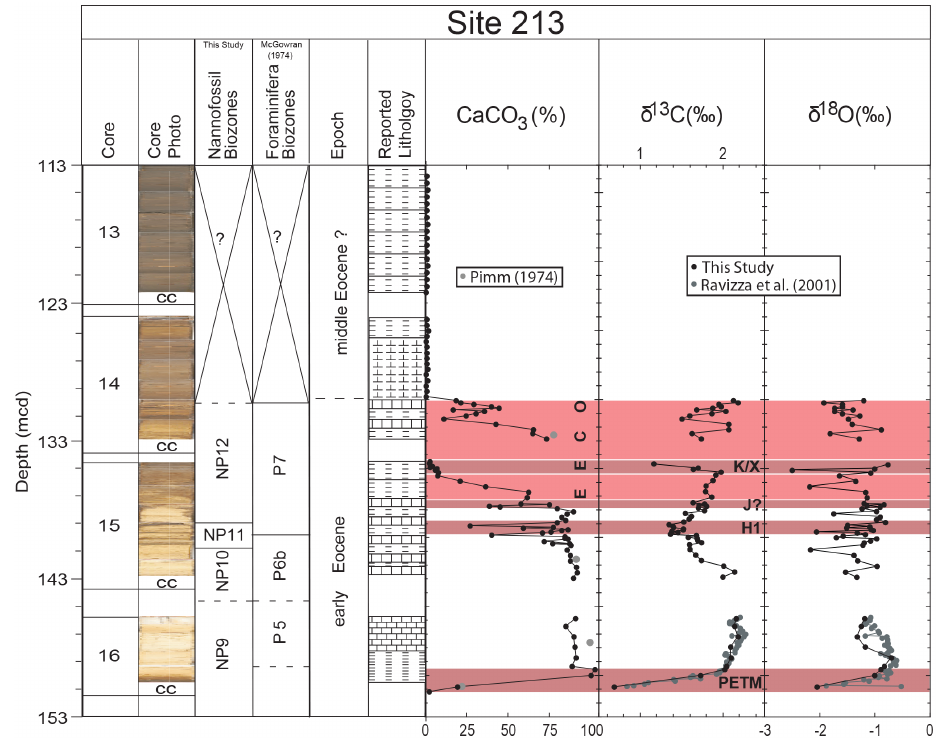
Figure 7. Early Paleogene sequences at DSDP Site 213. Biostratigraphy and lithology have been modified from the DSDP Leg 22 volume (von der Borch and Sclater, 1974). Core photos are sourced from the online database (www.iodp.org). Bulk carbonate δ 13 C and δ 18 O records near the base of Core 16 include data from previous work spanning the PETM recovery (grey – Ravizza et al., 2001). Carbonate content records include data from previous work (grey – Pimm, 1974). Consistent with the K/X event occurring near the NP11–NP12 zonal boundary (Agnini et al., 2007), the H, J, and onset of K/X events occur in Core 15 sections 15-4, 15-3, and 15-1, respectively. The H and I events may have been mixed together since rotary coring was used for core collection. The upper portion of core 15 and all of core 14 likely spans the EECO, as indicated by depleted δ 13 C and key zonal boundaries. Calcareous nannofossil NP biozones from Martini (1971) and foraminiferal P biozones from Berggren et al. (1995). Note lithological facies key in Fig.